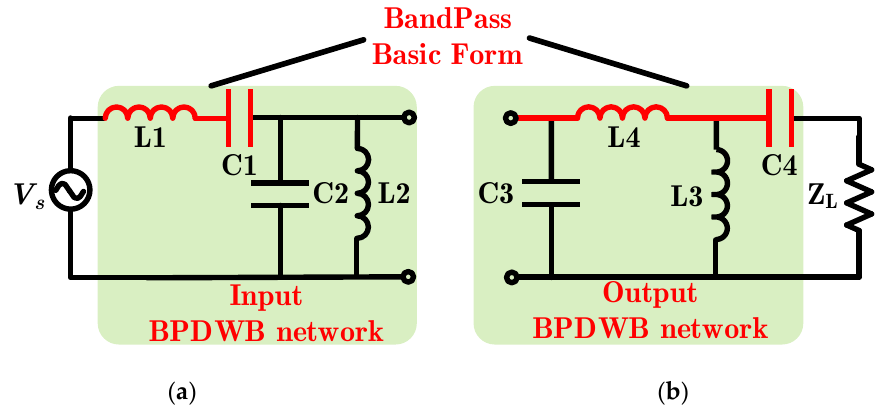
Figure 4. ( a ) The proposed input matching network based on BPDWB; ( b ) output matching network based on BPDWB.